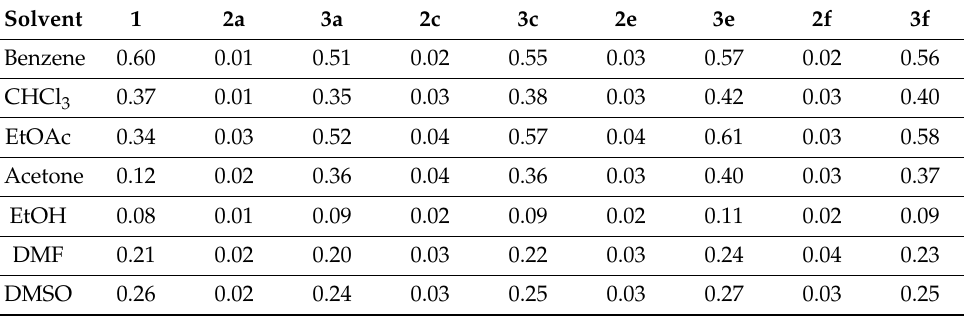
Table 4. Emission quantum yields of initial compound 1 and obtained derivatives 2 – 3 in various organic